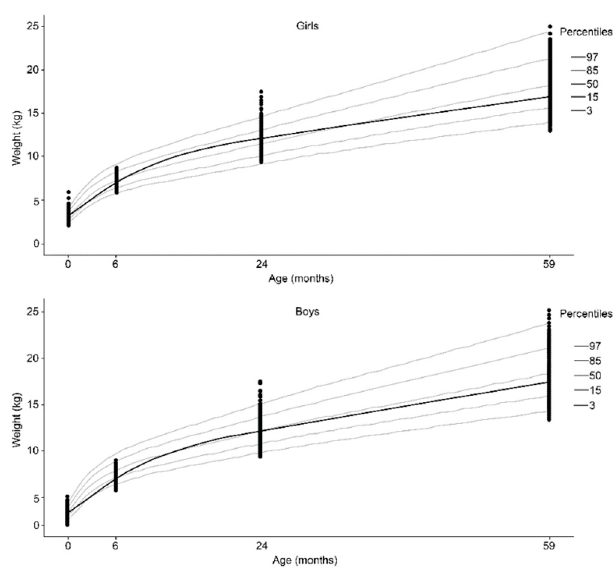
Figure 3. Weight according to age adjusted by the cubic spline function for both female ( upper ) and male ( lower ) sex.